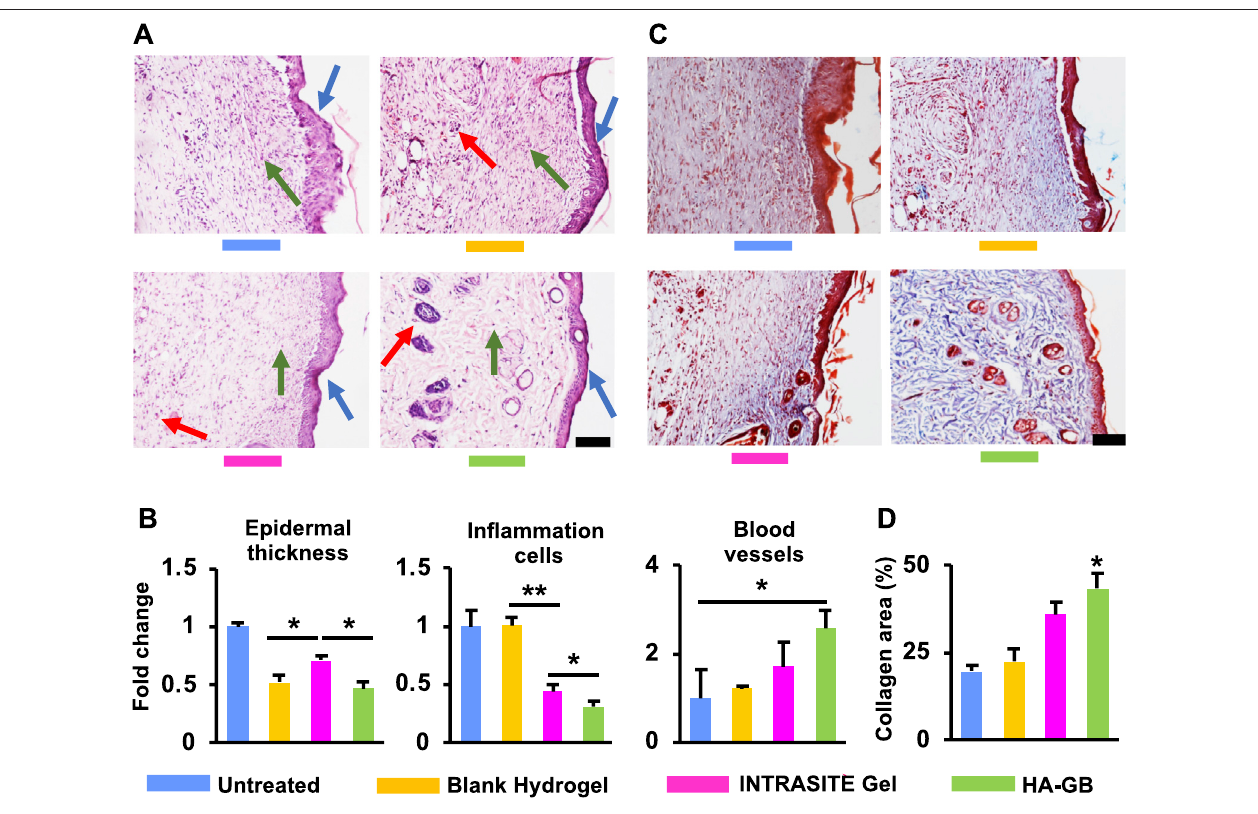
FIGURE 5 | The histological analysis. (A) In the H&E images on Day 7 (scale = 20 μ m), the in fl ammatory cells, epidermal hyperplasia and new blood vessels were indicatedbythegreen,blueandredarrows,respectively. (B) Thequanti fi cationof Figure5A ( n =6;* p < 0.05and** p < 0.01). (C) TheMasson ’ strichromeimagesonDay 14 (scale = 20 μ m) (red area = keratin, muscle fi bers and cytoplasm; blue area = collagens). (D) The quanti fi cation of Figure 5C ( n = 6; * p <